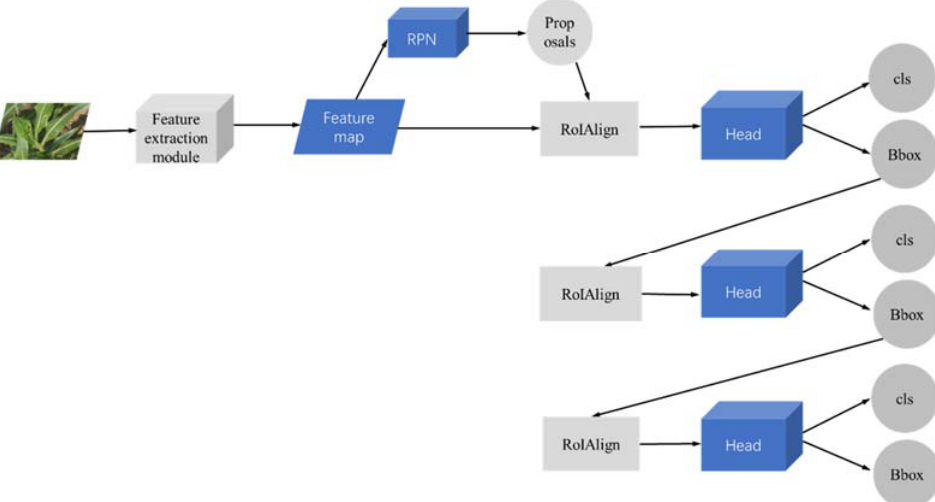
Figure 5. Overview of the Pest R-CNN detection model structure. The feature extraction module was used to extract multi-scale features of initial images for objection detection. Region proposal network (RPN) was used to generate region proposals, i.e., anchors. RoIAlign module was used to smoothly crop a patch from a full-image feature map based on a region proposal, and then resize the cropped patch to a desired spatial size. After RoIAlign module, features were processed with multi-layer structure prediction parts, i.e., three prediction heads, to generate more precise anchor position and classification results.